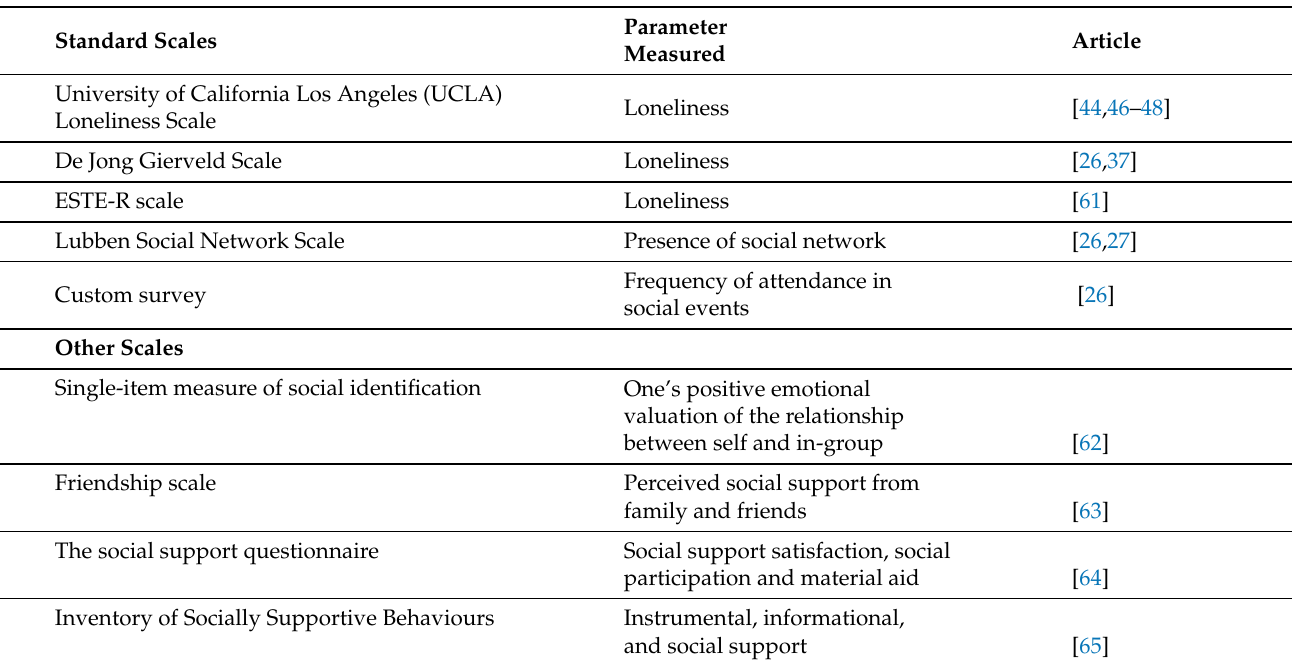
Table 3. Standard instruments used to measure social isolation and